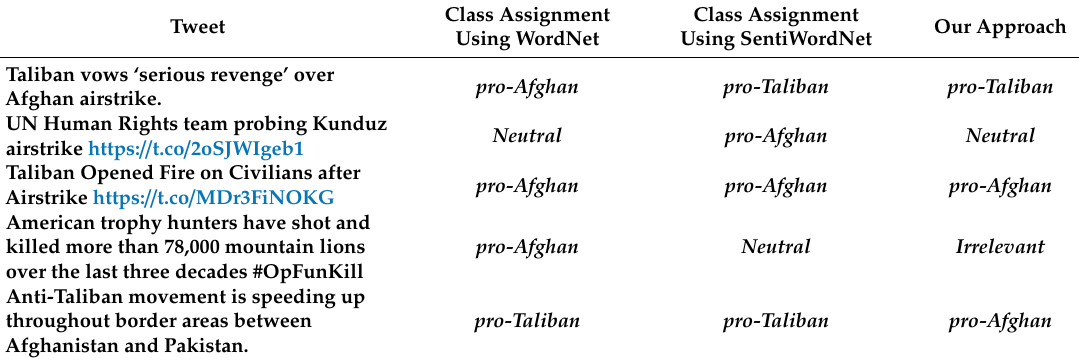
Table 3. Example of data labelling